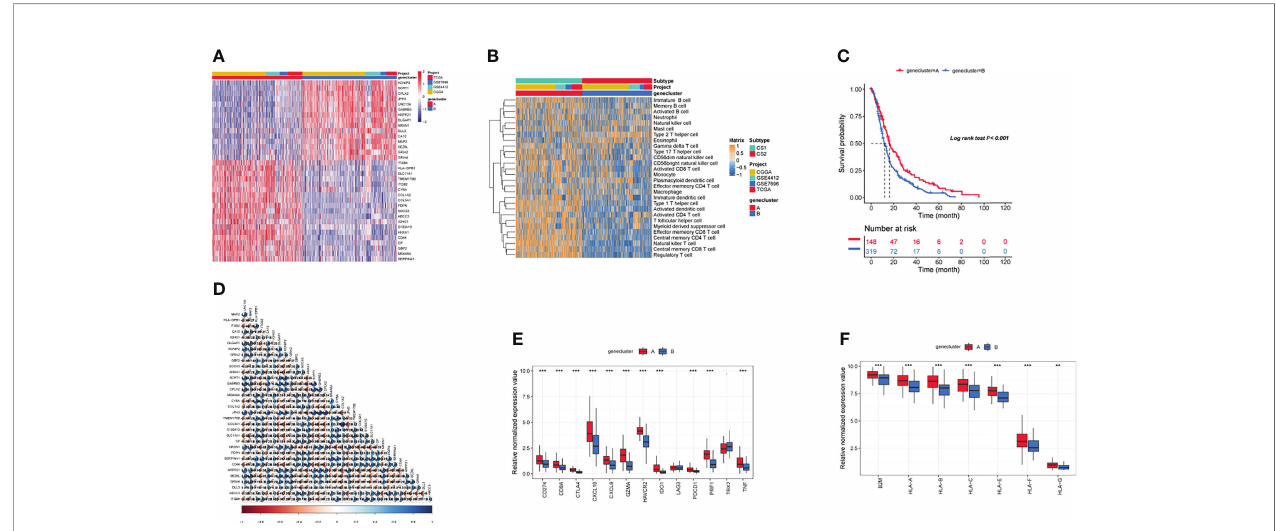
FIGURE 2 | Identi fi cation of gene subtypes. (A) The landscapes of 34 differentially expressed genes in the two gene clusters. (B) Heatmaps of in fi ltration of 28 immune cell types in different gene clusters. (C) Survival analysis in the two gene clusters. (D) The correlation in 34 genes in the tumor patients. (E) Expression of genes related to immune activation ( CD8A , CXCL9 , CXCL10 , GZMA , GZMB , IFNG , PRF1 , TNF , TBX2 ) and immune checkpoints ( CD274 , IDO1 , PDCD1 , HAVCR2 , LAG3 , CTLA4 ) within the two gene clusters. (F) The distribution of B2M and HLA genes in the two gene clusters. (**p ≤ 0.01; ***p ≤